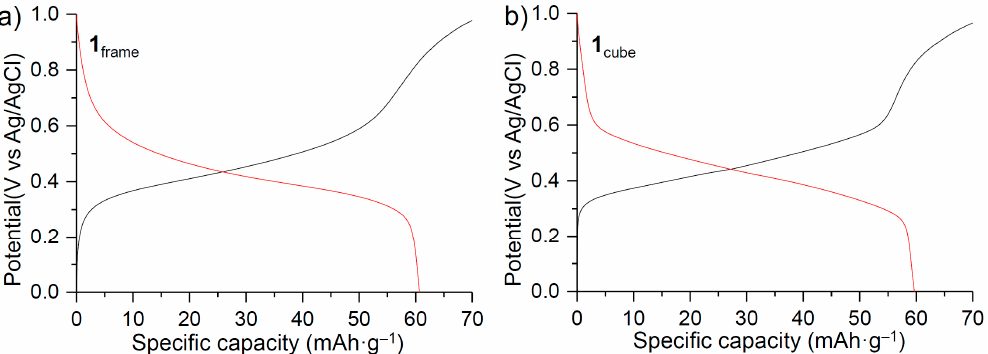
Figure 5. ( a , b ) Galvanostatic charge/discharge curves of 1 frame and 1 cube at a current density of 70 mA·g – 1 , respectively.